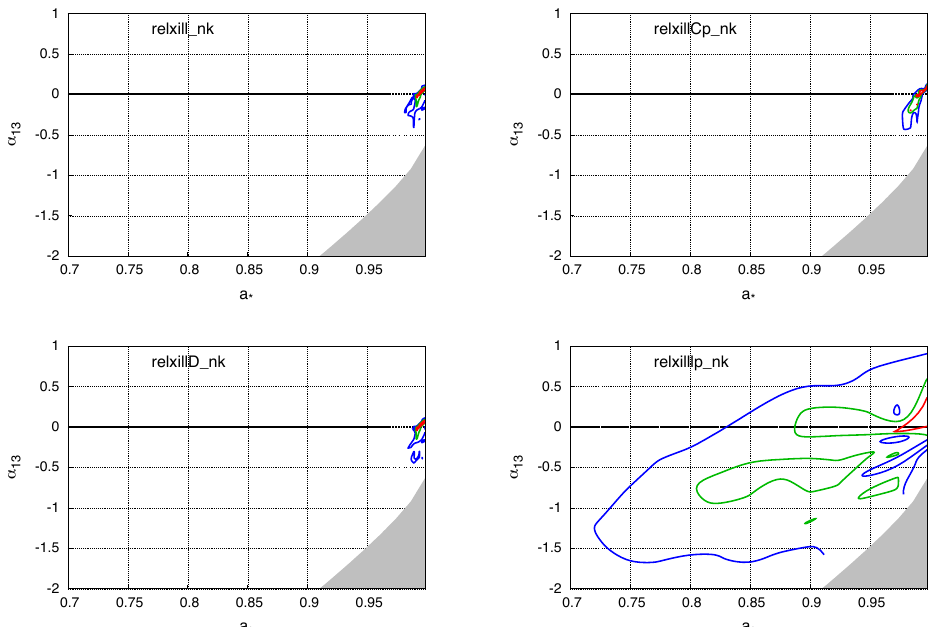
Figure A8. Constraints on the spin parameter a ∗ and the Johannsen deformation parameters α 13 for Swift J0501–3239 when the reflection component is modeled by RELXILL _ NK ( top left panel ), RELXILL C P _ NK ( top right panel ), RELXILL D_ NK ( bottom left panel ), and RELXILLLP _ NK ( bottom right panel ). The red, green, and blue curves are, respectively, the 68%, 90%, and 99% confidence level boundaries for two relevant parameters. The grayed regions are ignored in our analysis because the do not meet the condition in (8).